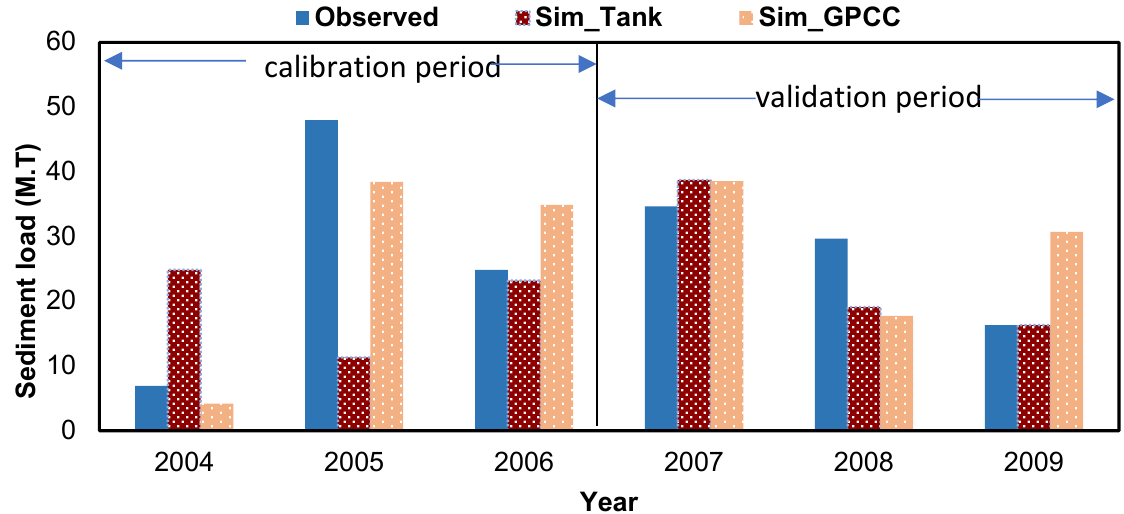
Figure 8. Simulated and observed sediment on an annual basis using the Tank and GPCC datasets. The simulated sediment yield using the precipitation gauge data was close to the computed one for the years 2006, 2007 and 2009. For the observed precipitation, the coefficient of determination (R 2 ) and Nash–Sutcliffe efficiency (NSE) were calculated as 0.89 and − 0.97, respectively, during the calibration period. The higher value of R 2 (i.e., 0.89) indicated the better performance of the SWAT model for sediment yield estimation. The negative value of NSE was due to over and underestimations of the annual sediment load during 2004 and 2005, respectively. This indicates that the observed sediment loads for 2004 and 2005 are more efficient than the simulated ones. However, the computed sediment yield in 2006 was in very close agreement with the observed sediments, i.e., − 6.7%. The computed sediment yield for the validation period (2007–2009) possessed a better value of NSE, i.e., 0.28. The differences between observed and simulated sediment loads for